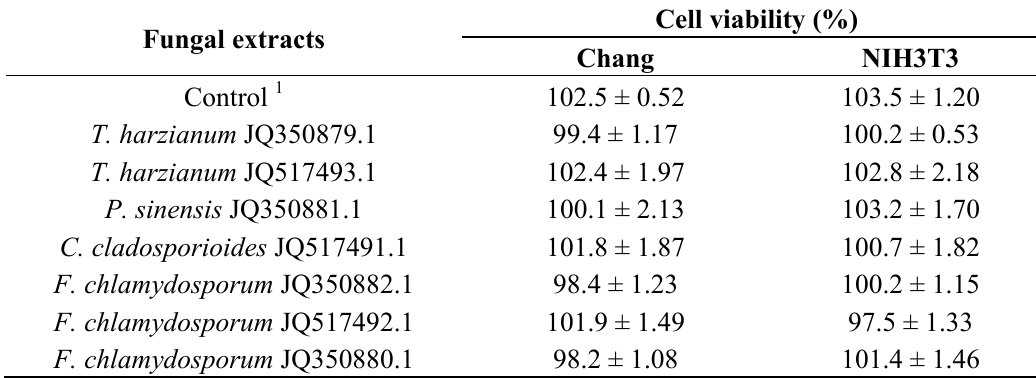
Table 3. Percentage of cell viability of Chang liver and NIH 3T3 cell lines exposed to 250 µg/mL of DMSO extract obtained from fungal cultures without PEs-rich fraction after 7